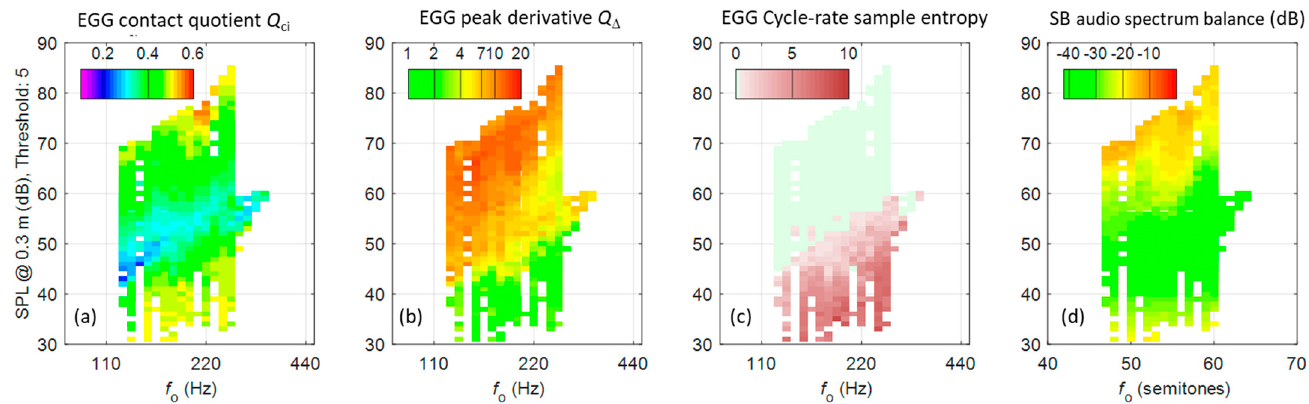
Figure 1. A healthy male amateur choir singer sang repeated messa di voce exercises (soft-loud-soft on constant pitch) over a limited range of one octave, and four voice metrics were mapped. ( a ) EGG contact quotient Q ci [15], ( b ) normalized peak EGG derivative Q Δ , ( c ) EGG cycle-rate sample entropy, and ( d ) audio spectrum balance. The resulting images can be thought of as four different “layers” of one composite voice map. This voice map shows averaged data from over 60,000 phonatory cycles and took about six minutes to record. For these graphs, a minimum of five phonatory cycles was required in each cell. For semitones, the MIDI scale is used, in which middle C4 (261 Hz) is assigned the scale number 60. (Previously unpublished data, collected for [14].)